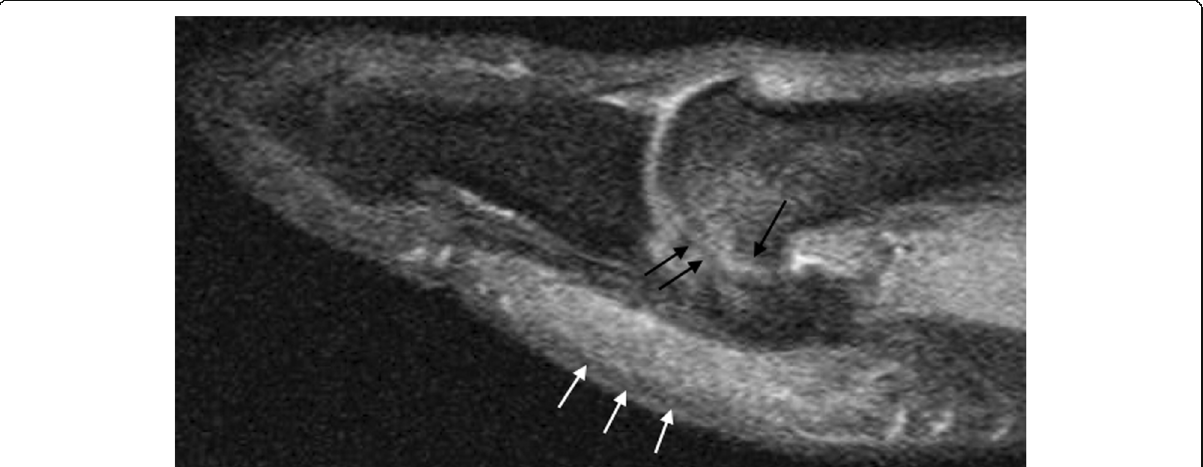
Fig. 12 Sesamoiditis. A 39-year-old woman, referred with the suspicion of sesamoiditis. Sagittal Fast FSE PD fat sat demonstrates increased signal intensity in both aspects of the sesamoid — metatarsal joint, with loss of cartilage and narrowing of the joint space (black arrows), as well as associated increased signal intensity in the subcutaneous tissue fat in the plantar aspect (white arrows). Findings are in keeping with degenerative change in joint, but there